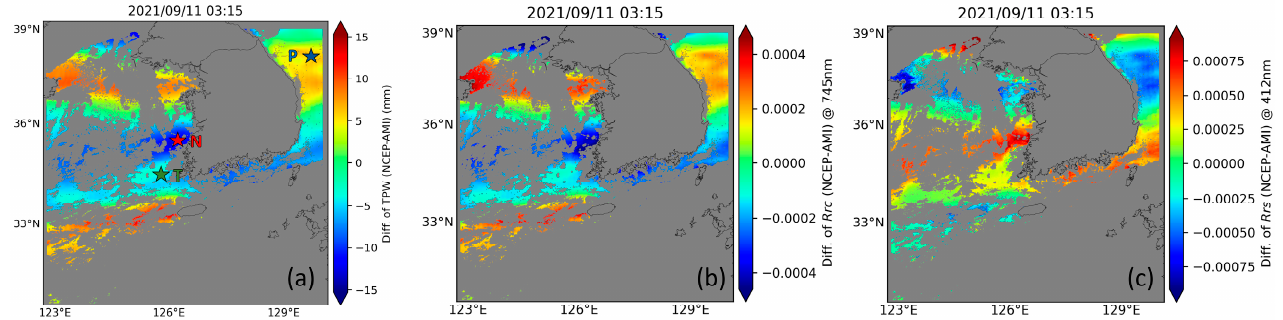
Figure 4. Differences in ( a ) TPW, ( b ) Rayleigh-corrected reflectance at 745 nm, and ( c ) remote sensing reflectance at 412 nm obtained using different TPW sources (NCEP and AMI) at 03:15 UTC on 11 September 2021. Gray shading indicates masked regions corresponding to land, cloud cover, and beyond the slot. “T” and “N” represent pixels with positive and negative differences in TPW (NCEP–AMI) in clear water, respectively, while “P” represents a pixel in turbid water.